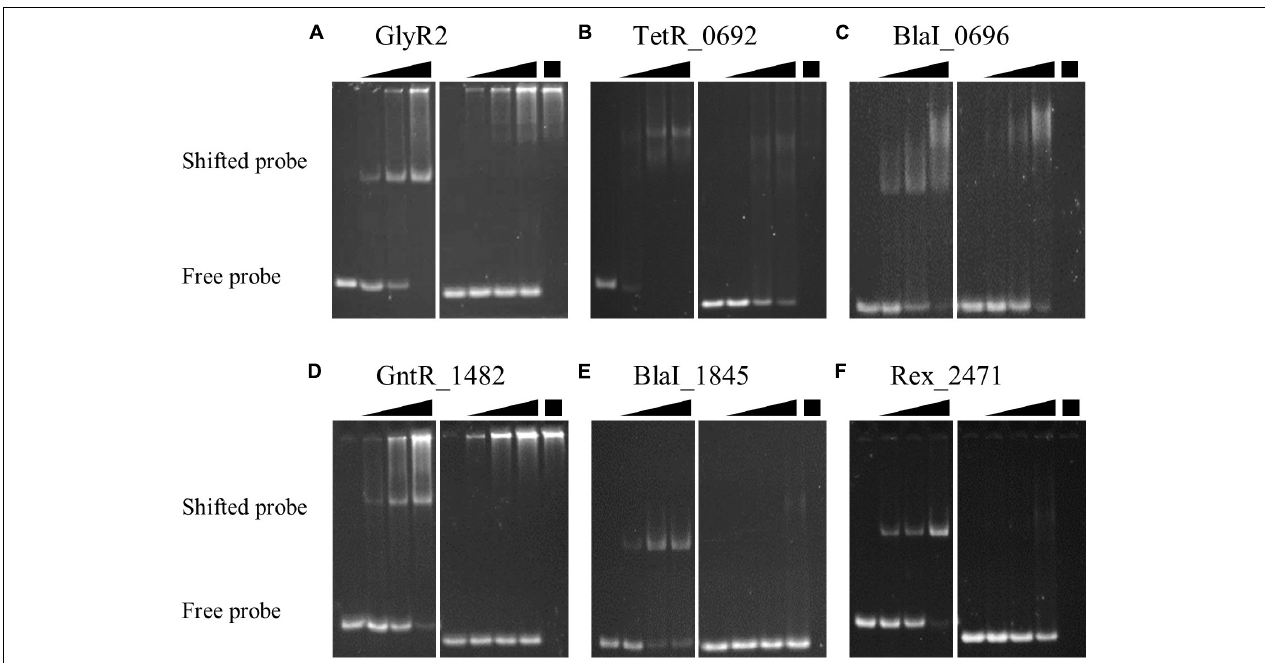
FIGURE 3 | Sequence-specific binding of TFs to DNA. Single-step purified TFs were tested for binding to double-stranded DNA probes with or without the DAP-seq derived motif using EMSAs. Six TFs were of sufficient purity and quantity to demonstrate sequence specific binding: (A) GlyR2 (Clo1313_0089); (B) TetR _0692; (C) BlaI _0696; (D) GntR _1482; (E) BlaI _1845; and (F) Rex _2471. Free probes migrate further into the gel than probes in a TF-DNA complex. Gels for each TF were split into two subpanels to show binding to DNA probes with our identified motif (left) and to probes without the motif (right) of the respective TF. In each